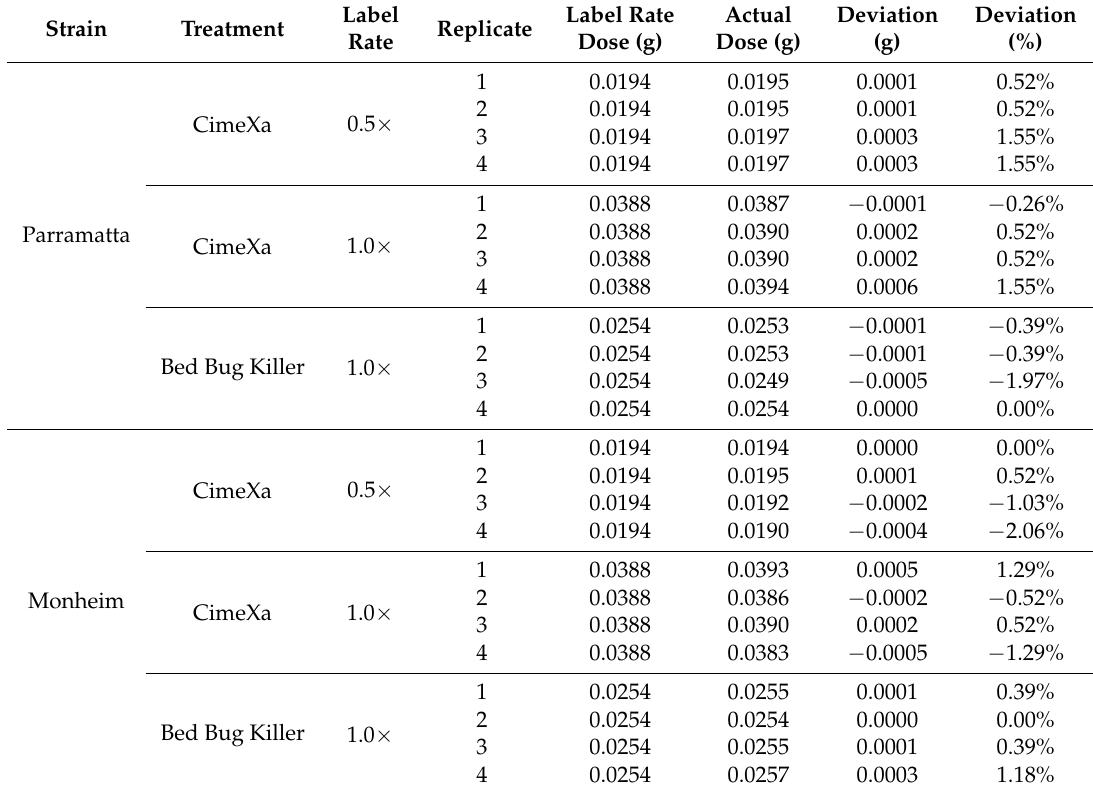
Table 1. Calculated and applied rates of CimeXa Insecticide Dust and Bed Bug Killer Powder. Strain Treatment